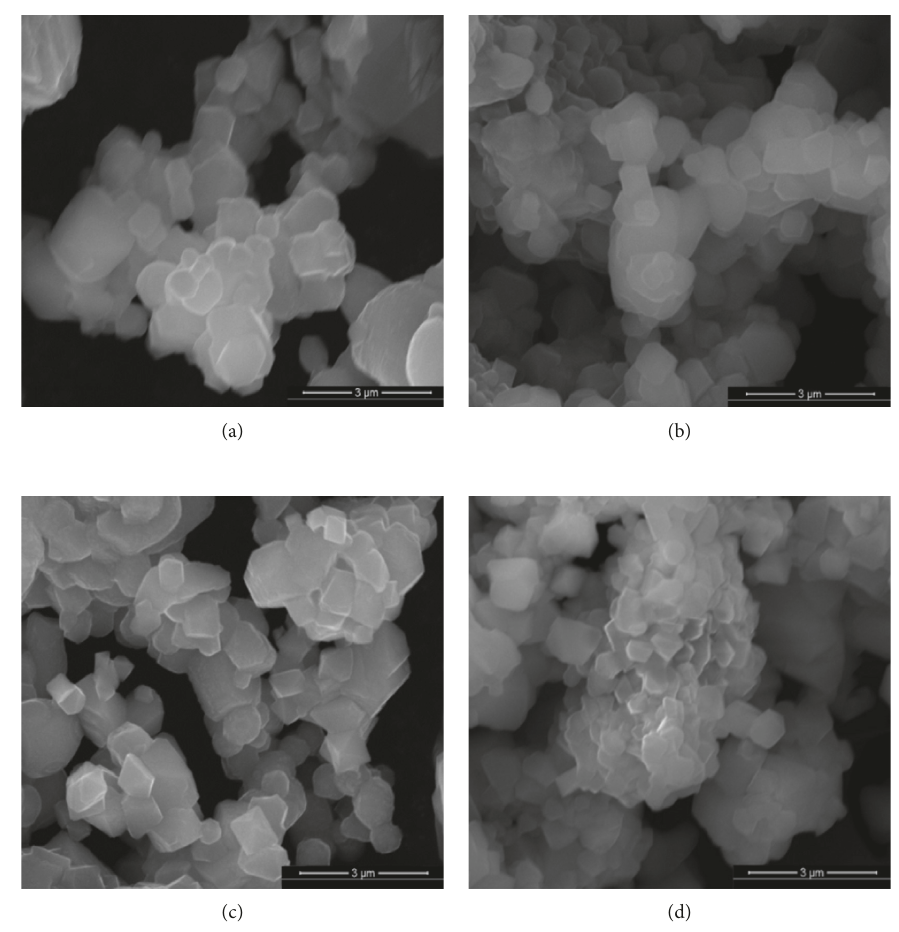
Figure 4: SEM images of products prepared at various temperatures of (a) 700 ° C, (b) 750 ° C, (c) 800 ° C, and (d) 850 °